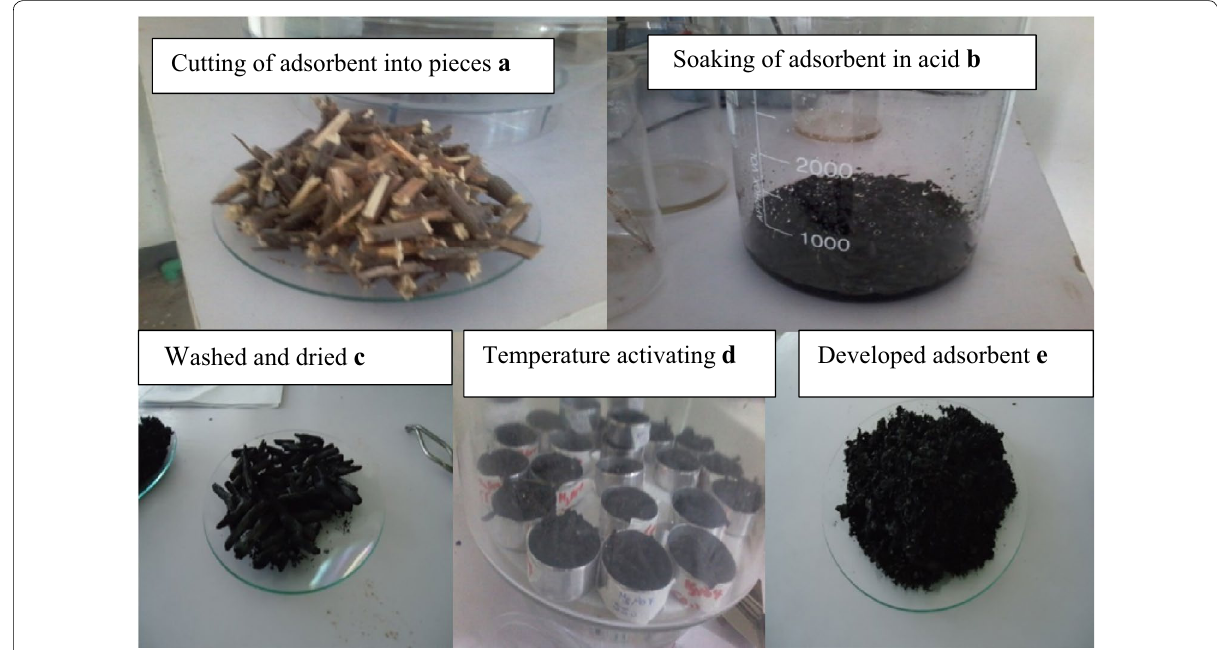
Fig. 1 Different stages of the activated carbon